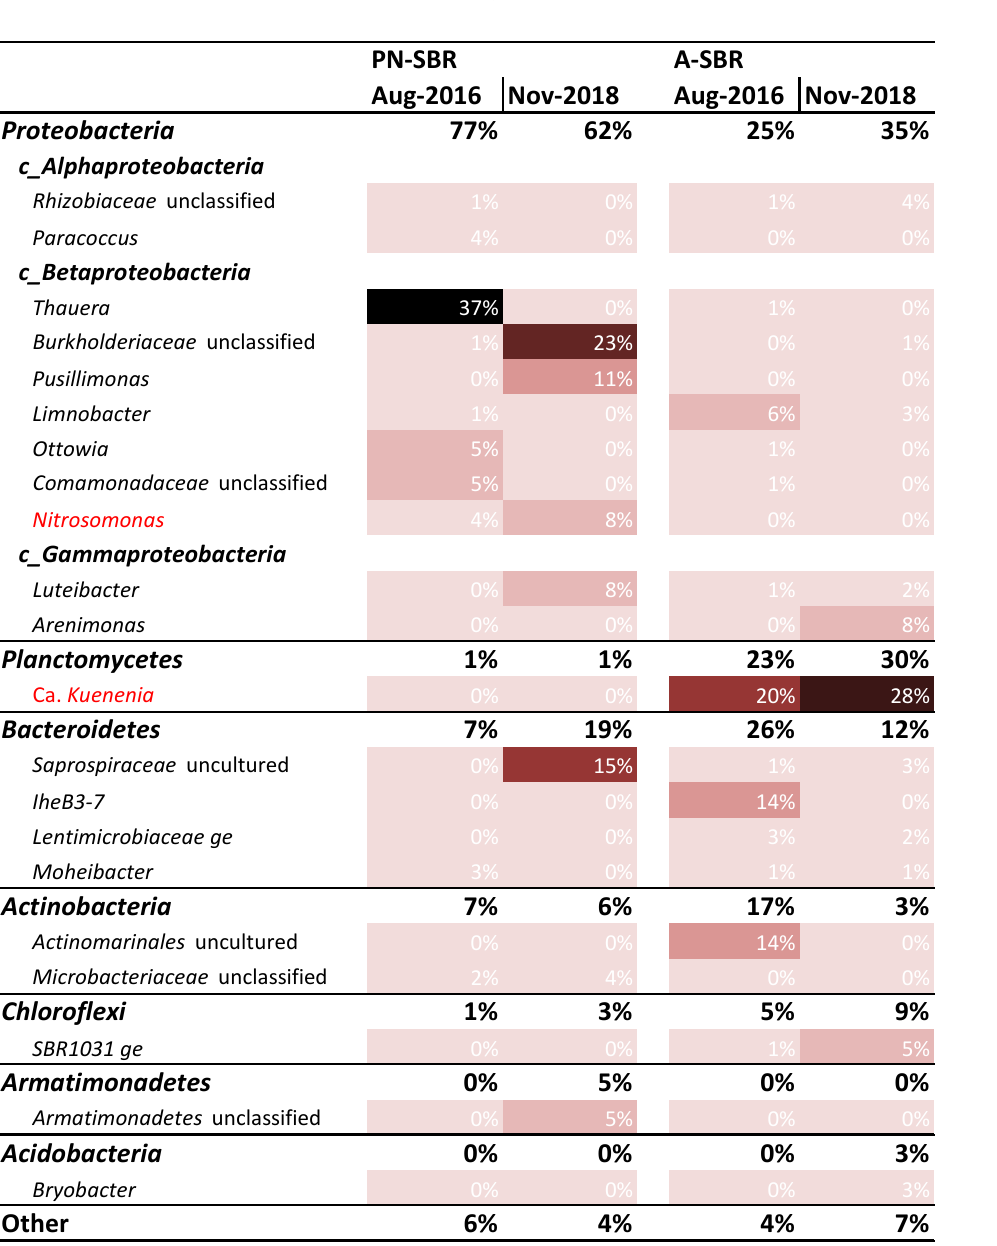
Figure 8. Relative abundance of the main bacterial representatives at the phylum and genus levels in both SBRs (PN-SBR and A-SBR) at two different times (August 2016 and November 2018). The community was analyzed by high-throughput sequencing using the Illumina MiSeq platform. Nitrosomonas as the dominant genus for AOB and Ca. Kuenenia as the dominant genus for AnAOB are indicated in red